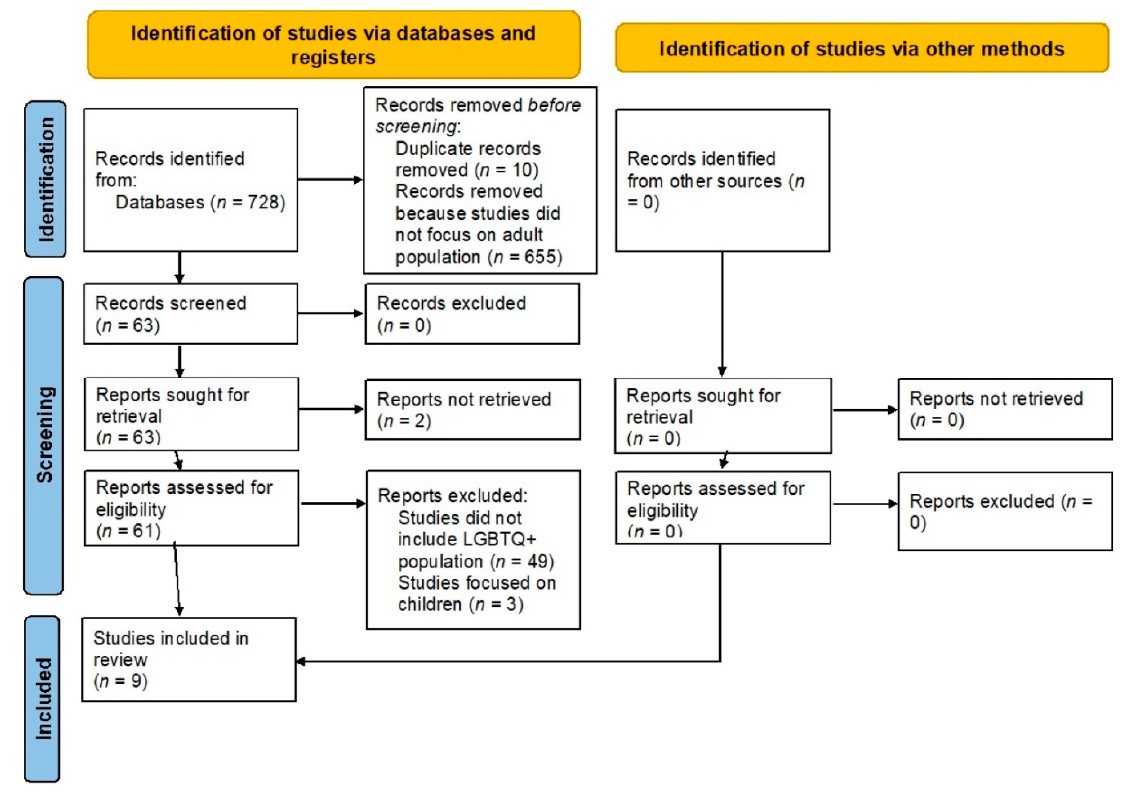
Figure 1. PRISMA diagram.